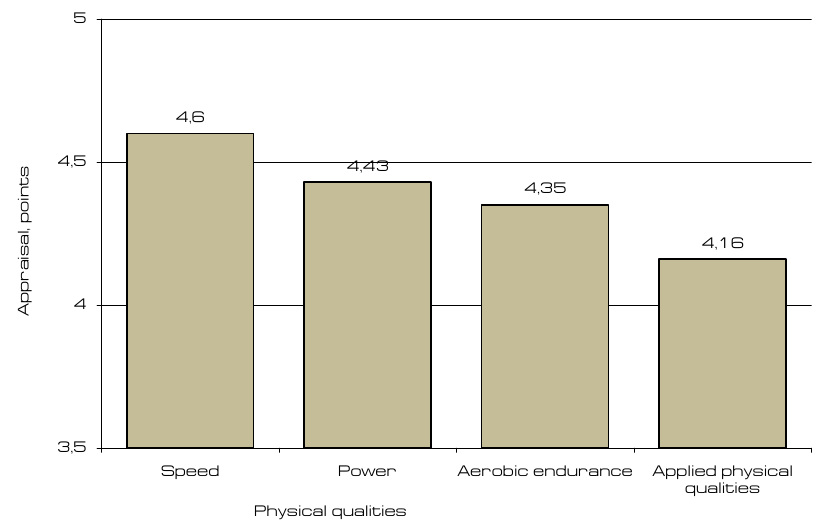
Fig.1. Level of general and applied physical qualities of KUAF graduates 2011